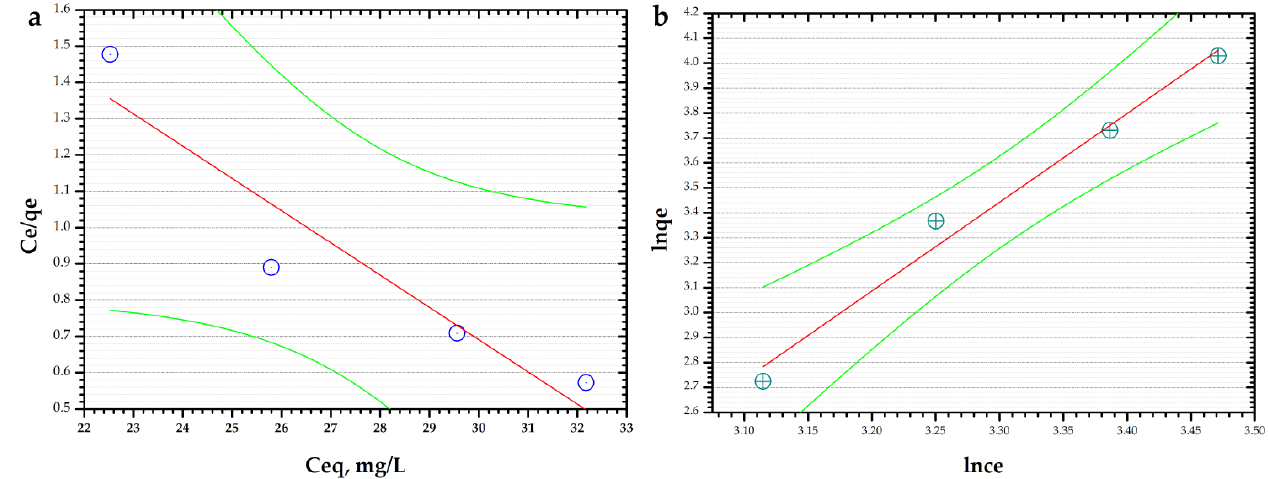
Figure 9. ( a ) Langmuir isotherm model; ( b ) Freundlich isotherm model.